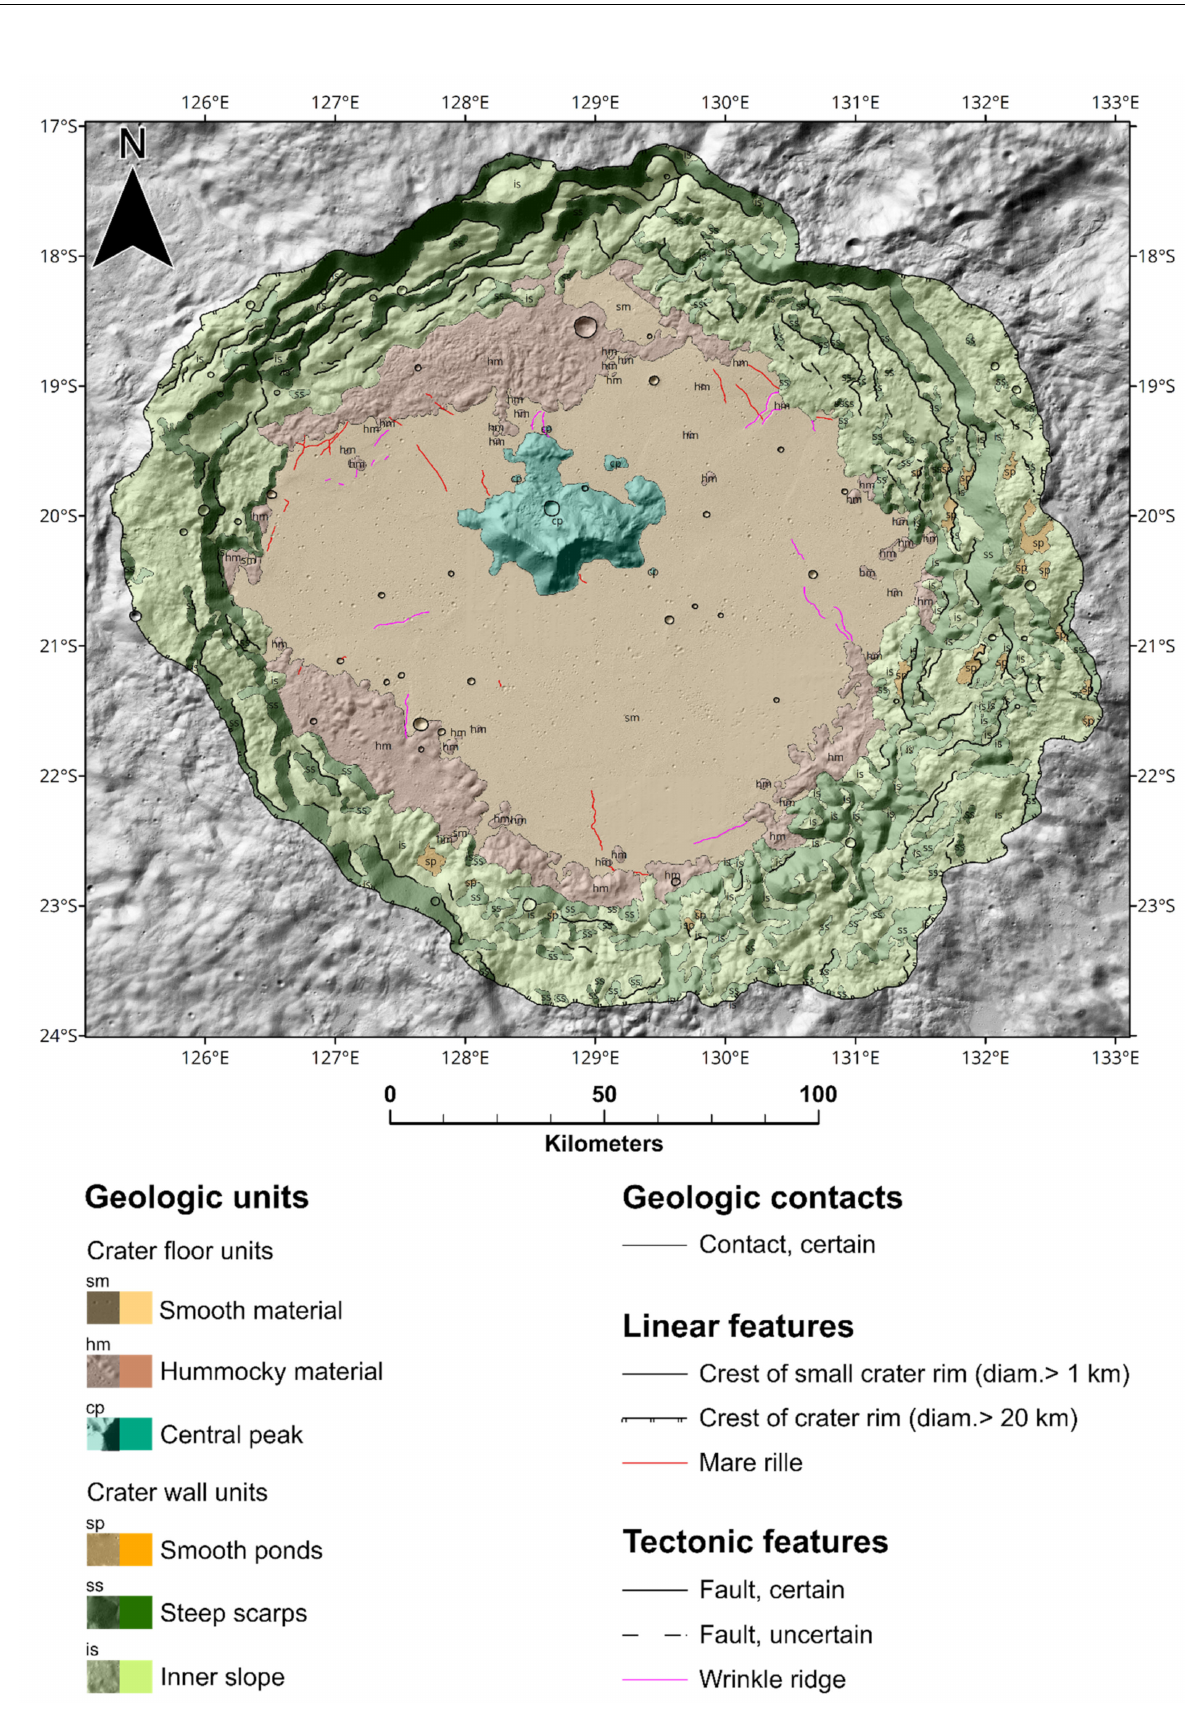
Figure 5. Morpho-stratigraphic map of Tsiolkovskiy visualized on top of the DEM-derived hillshade. Refer to the text for unit